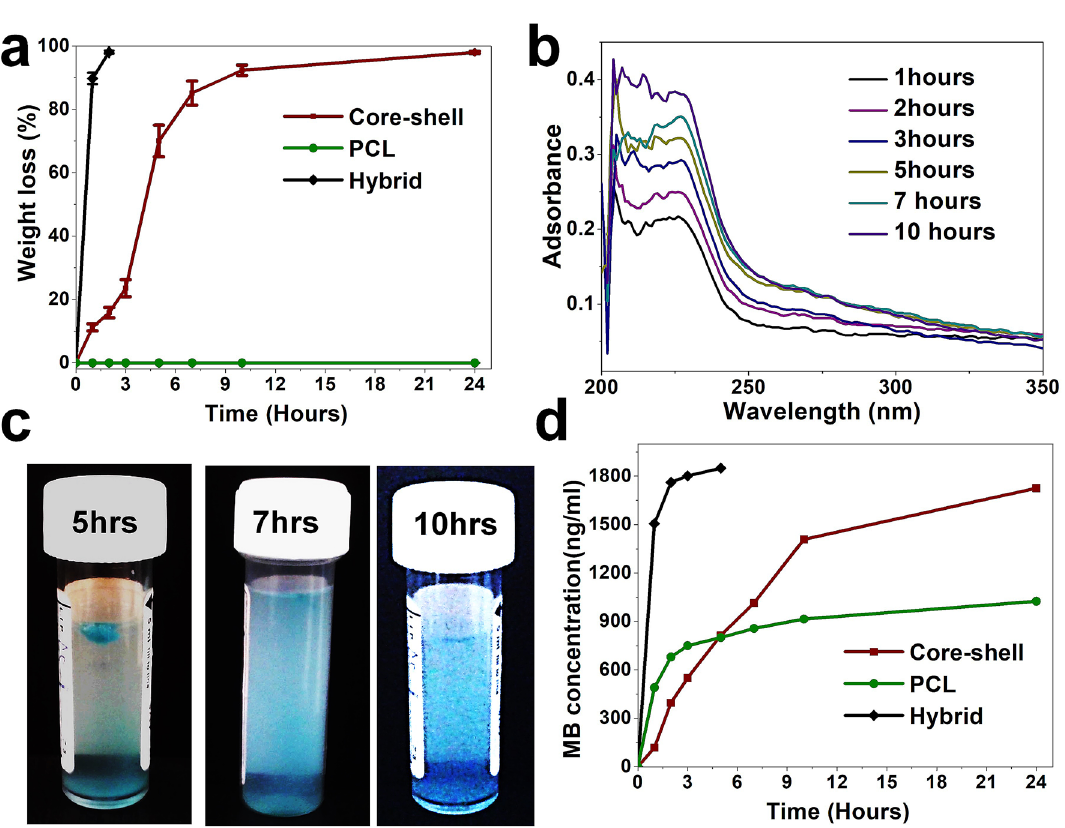
Figure 5. Weight change of the electrospun fiber under PBS (pH 7.4) (a) , UV spectra change and representative color change of the PBS solution after immersing the core–shell fibrous sheet (b,c) , and methylene blue release profile from the electrospun scaffolds (d) . The photo was taken by first author Tuerdimaimaiti Abudula. Overall results imply the role of PCL shell layer coating on the CL based hybrid scaffold in preventing burst release and providing prolonged drug release